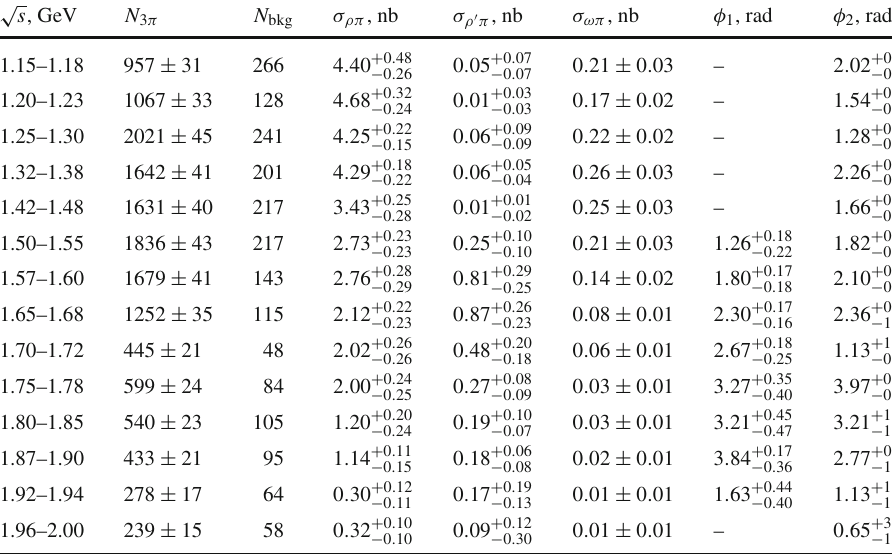
Table 3 The c.m. energy √ s ), number of interval ( selected e + e − → π + π − π 0 events ( N 3 π ), number of background events ( N bkg ), cross sections for intermediate states ρ( 770 )π ( σ ρπ ), ρ( 1450 )π ( σ ρ (cid:6) π ), and ωπ 0 ( σ ωπ ),